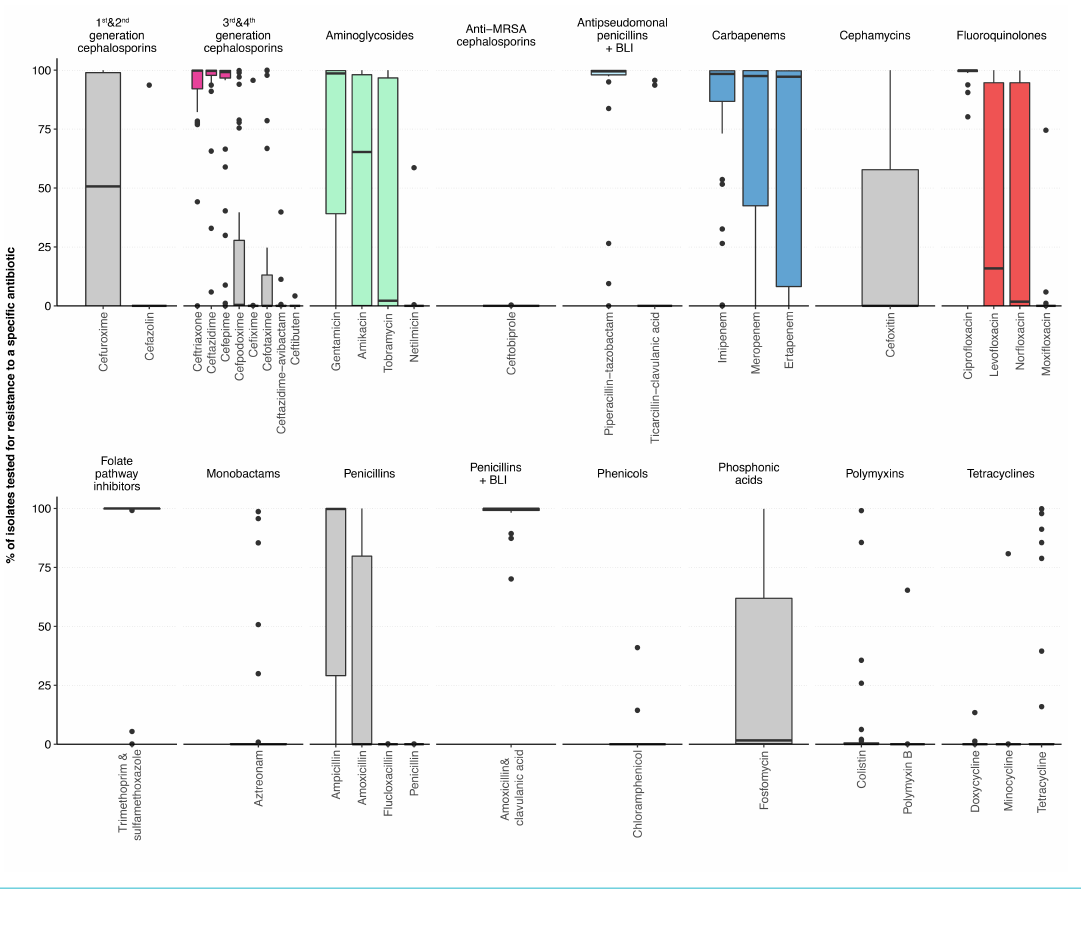
Figure S2: Proportion of Enterobacterales blood culture isolates per laboratory tested for certain antibiotics among the antibiotic categories defined by the ECDC. The most frequently tested antibiotics in the five antibiotic categories important for the definition of gram-negative MDR are highlighted in colour. Boxplot with horizontal line for the median of the proportion of isolates tested for an antibiotic per laboratory. Boxes represent the first and third quartile, whiskers extend either to the extreme values of the observations or to 1.5 times the interquartile range, and the dots indicate the laboratories declared as outliers. BLI, β-lactamase inhibitor; ECDC, European Centre for Disease Prevention and Control; MDR, multiple drug resistance; MRSA, methicillin-resistant Staphylococcus